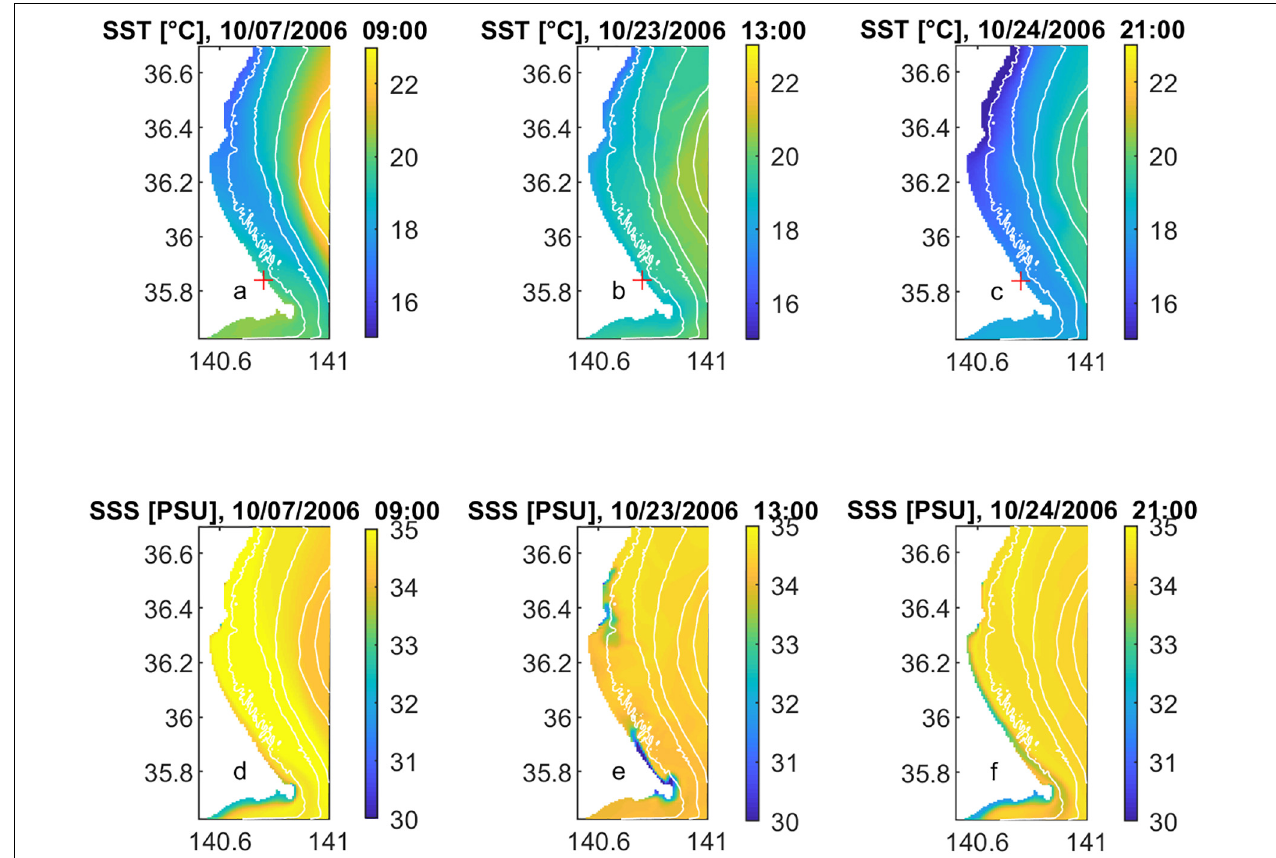
FIGURE 10 | Sea Surface Temperature (upper) and Sea Surface Salinity (lower) for October 7 at 9 am (left) , October 23 at 1 pm (middle) and October 24 at 9 pm (right) . Bathymetry contours represent depths of 25, 50, 100, and 200 m. Red cross indicates the location of the corresponding observed